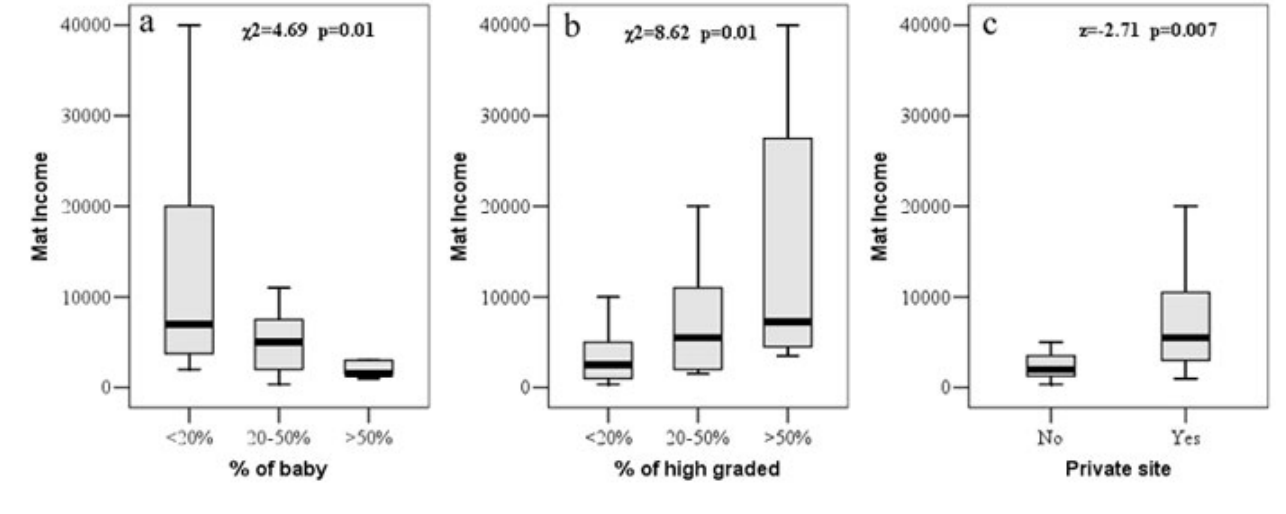
Fig. 5. Box plot showing harvesting behavior related to income